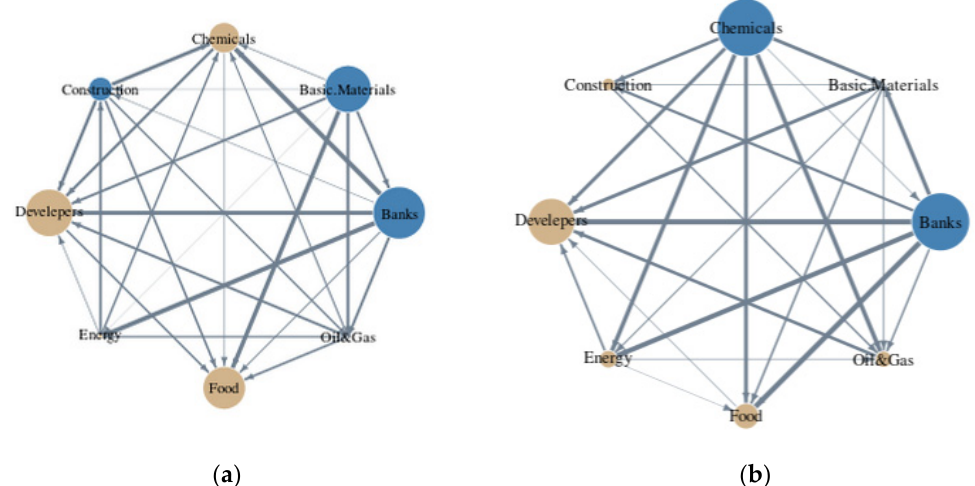
Figure 7. Net volatility spillovers between pairs of sectors in the Polish stock market. ( a ) In the period of 1 January 2013–31 December 2019 (before the crisis caused by the outbreak of COVID-19); ( b ) in the period of 1 January 2020–2 December 2021 (during the crisis caused by the outbreak of COVID-19).